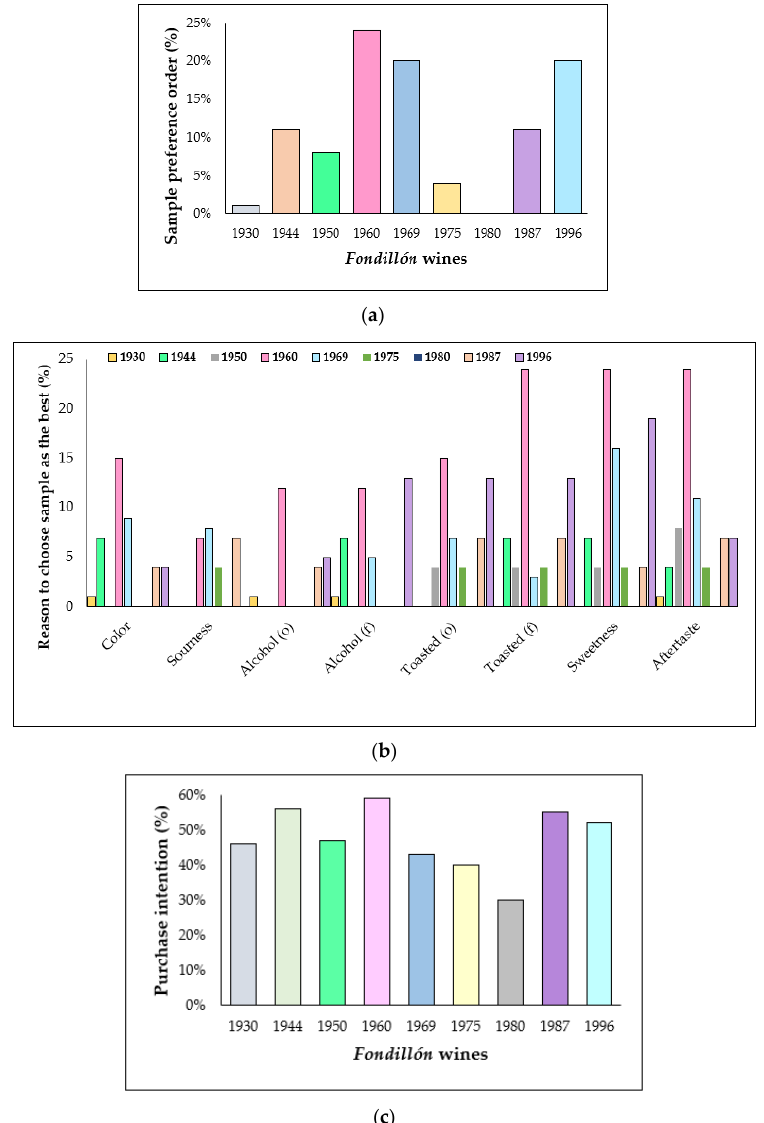
Figure 2 . Consumer preference ( a ); main reasons to choose 1960 Fondillón as the favorite ( b ); and purchase intention ( c ). Figure 2. Consumer preference ( a ); main reasons to choose 1960 Fondill ó n as the favorite ( b ); and purchase intention ( c